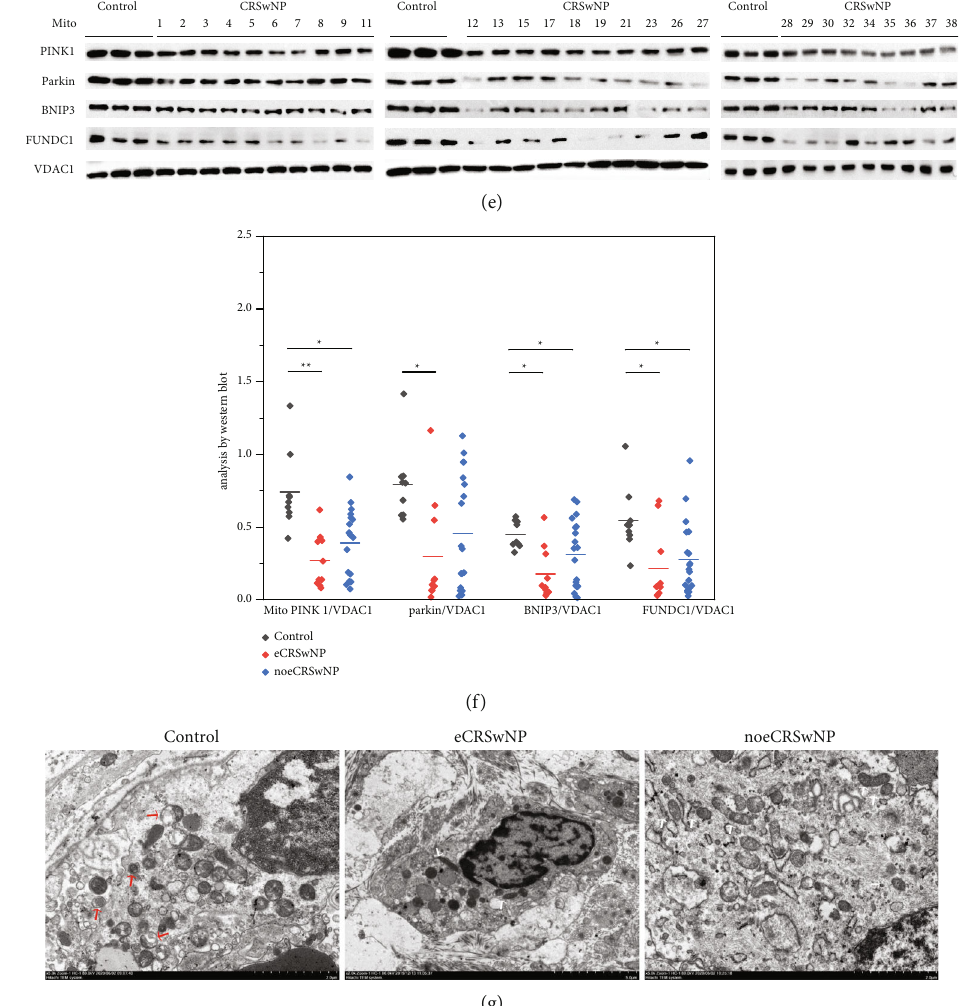
Figure 4: Mitophagy levels in di ff erent CRSwNP subtypes. (a, b) The IHC analysis of nasal tissues showed that the expression of PINK1, BNIP3, and FUNDC1 proteins was signi fi cantly reduced in patients with eCRSwNP or noeCRSwNP, compared with control tissues. (c, d) Western blot analysis of total proteins revealed reduced levels of PINK1, parkin, BNIP3, and FUNDC1 in the nasal polyps of patients with eCRSwNP or noeCRSwNP, compared with control tissues. (e, f) Western blot analysis of mitochondrial proteins revealed signi fi cantly reduced levels of PINK1, parkin, BNIP3, and FUNDC1 in the nasal polyps of patients with eCRSwNP, compared with control tissues. Similar results were found for patients with noeCRSwNP, with the exception of parkin protein levels. (g) TEM showed that mitochondrial autophagosomes formed less frequently in the nasal polyps of patients with eCRSwNP or noeCRSwNP, compared with control tissues. Red arrow: mitochondrial autophagosomes. White arrow: mitochondria. ∗ P < 0 : 05 , ∗∗ P < 0 : 001